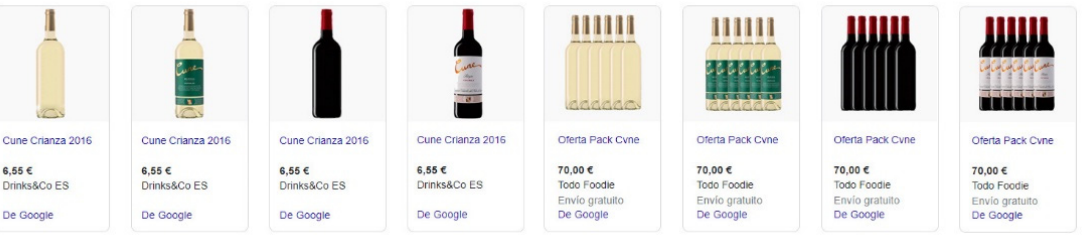
Figure 1. Designed